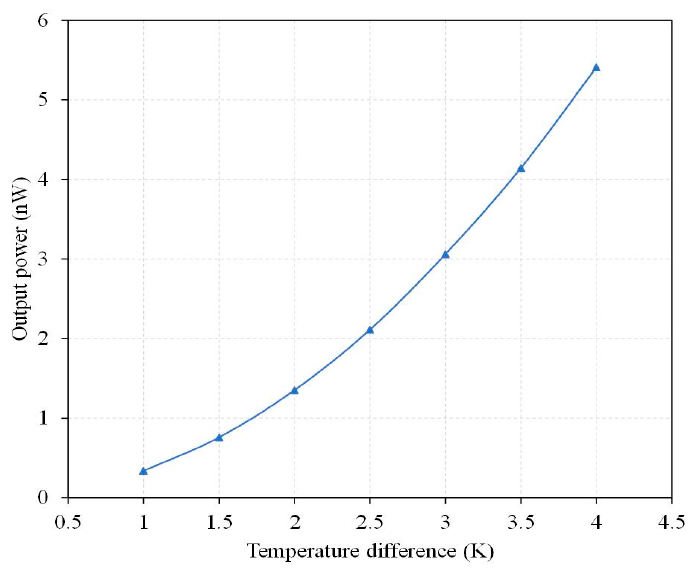
Figure 4. Evaluation of the maximum output power for the TEMH.